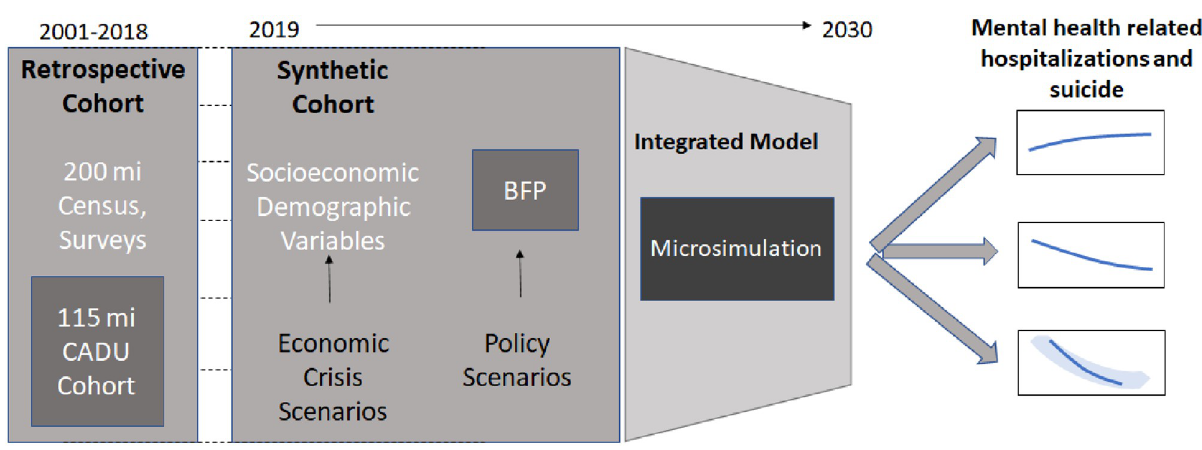
Fig 3. Integrated microsimulation model